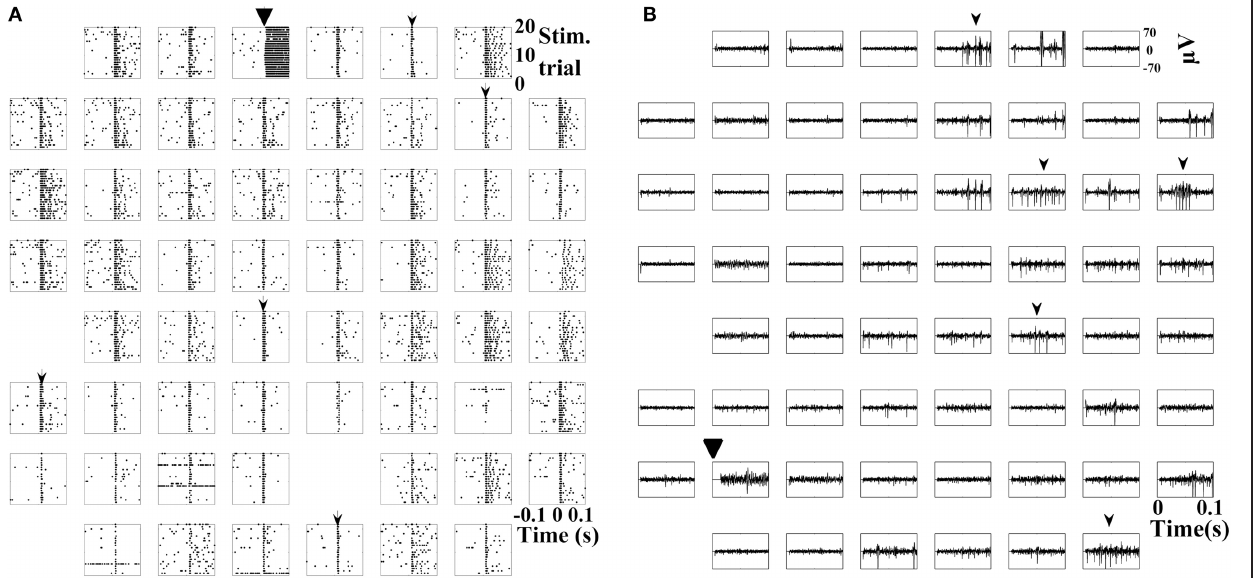
FIGURE 6 | Stimulus-evoked dAPs and synaptic activity with oscillations. (A) Detected spikes (.) over 20 trials ( y -axis) 100ms before and after a 0.5V stimulus (large black arrowhead) only on that electrode. Raster plots are oriented to recording electrode location. Small arrowheads designate dAPs on fiveofthe electrodes although they arepresent onmostelectrodes. (B) 100ms